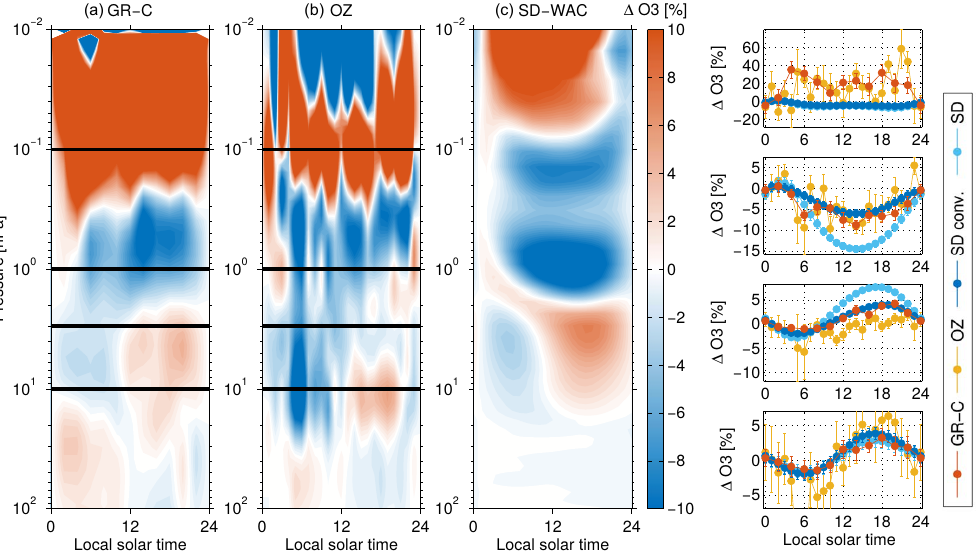
Figure 12. Same as in Fig. 9 but averaged over 30 days starting on 1 May 2016. The variability in the OZORAM data set is not of atmospheric origin but is an artefact of a small data set during